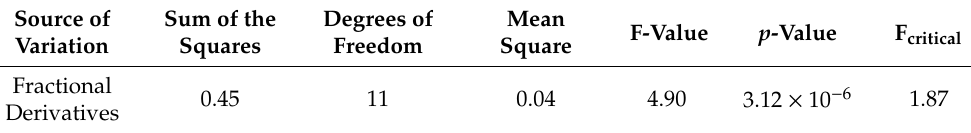
Table 4. Analyses of variance of the RMSE values of fractional